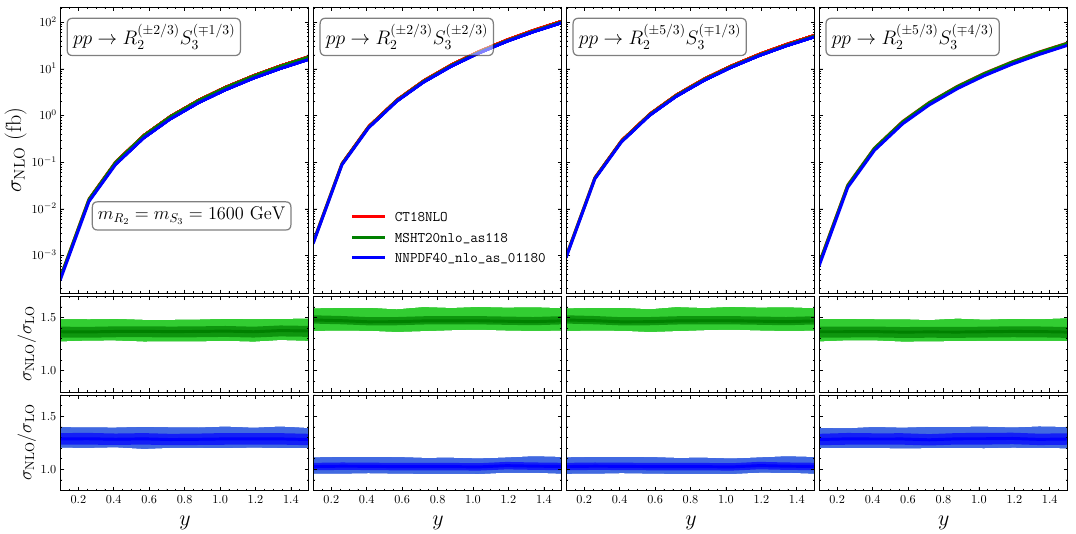
Figure 4 . Same as in figure 2 but for the off-diagonal processes pp → R ( ± 2 / 3) column), pp → R ( ± 2 / 3) S ( ± 2 / 3) (second column), pp → R ( ± 5 / 3) 2 3 R ( ± 5 / 3) S ( ∓ 4 / 3) (fourth column). Cross sections and K -factors are presented as a function of the 2 3 leptoquark Yukawa coupling y = y LR = y LL 2 , 12 3 , 12